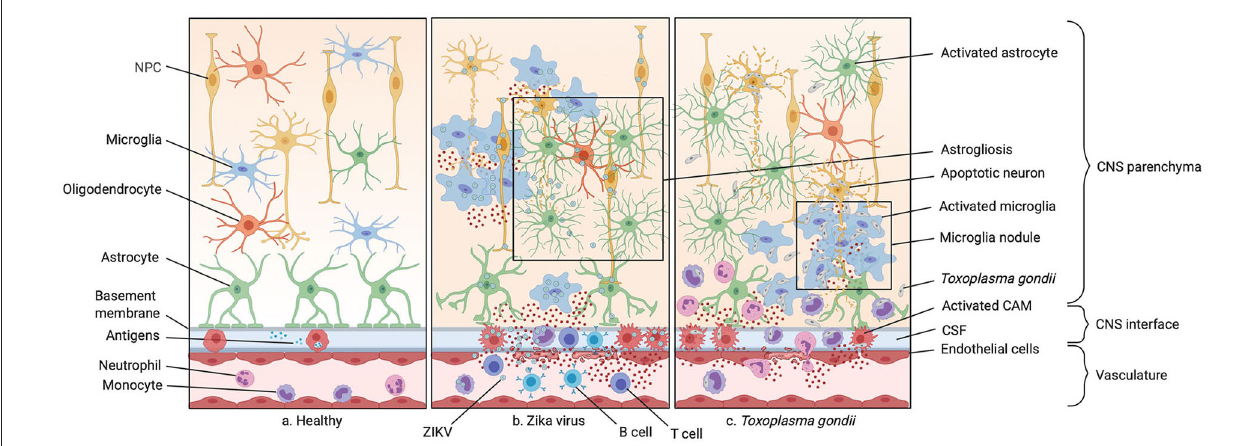
FIGURE 2 | Infections of the prenatal CNS. (a) Illustration of the healthy central nervous system (CNS) including the vasculature, the perivascular space, and the brain parenchyma. (b) A typical ZIKV infection mostly affecting CNS macrophages inducing neuronal progenitor cell (NPC) apoptosis and recruiting peripheral monocytes and neutrophils to the site of infection via various cytokines and chemokines. The blood-brain barrier (BBB) integrity is compromised in this process. Microgliosis, astrogliosis and microglia nodules around NPC bodies are often observed. (c) A typical parasitic CNS infection by Toxoplasma gondii is shown. The pathogen gains access to the CNS with the help of circulating monocytes, carrying the parasite to through the compromised BBB, also known as a “Troian horse” infection. This causes microglia nodules, abundant cytokine release by microglia and CNS-associated macrophages (CAMs), and subsequent infiltration by monocytes and